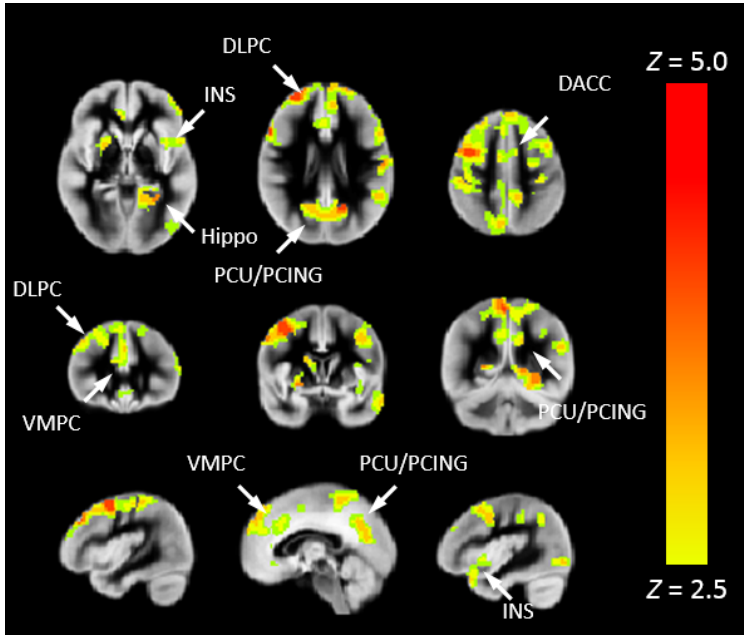
Figure 4. Pnvf positively correlates with neurocognitive outcomes in children and younger adults with CHD and normal referents. Regions with a positive correlation of Pnvf with the NIH Toolbox Total Cognition composite score (controlling for age, gender, and CHD status) are mainly concentrated in DMN, SN, and CEN regions as well as hippocampus and putamen. All regions depicted with yellow voxels demonstrate significant positive correlation with neurocognitive outcomes at FDR-corrected q < 0.05. Abbreviations: Ventrolateral medial prefrontal cortex (VMPC), Insula (INS), Dorsolateral prefrontal cortex (DLPC), Posterior Cingulate (PCING), Precuneus (PCU), Dorsal Anterior Cingulate Cortex (DACC), Posterior Parietal (PP).